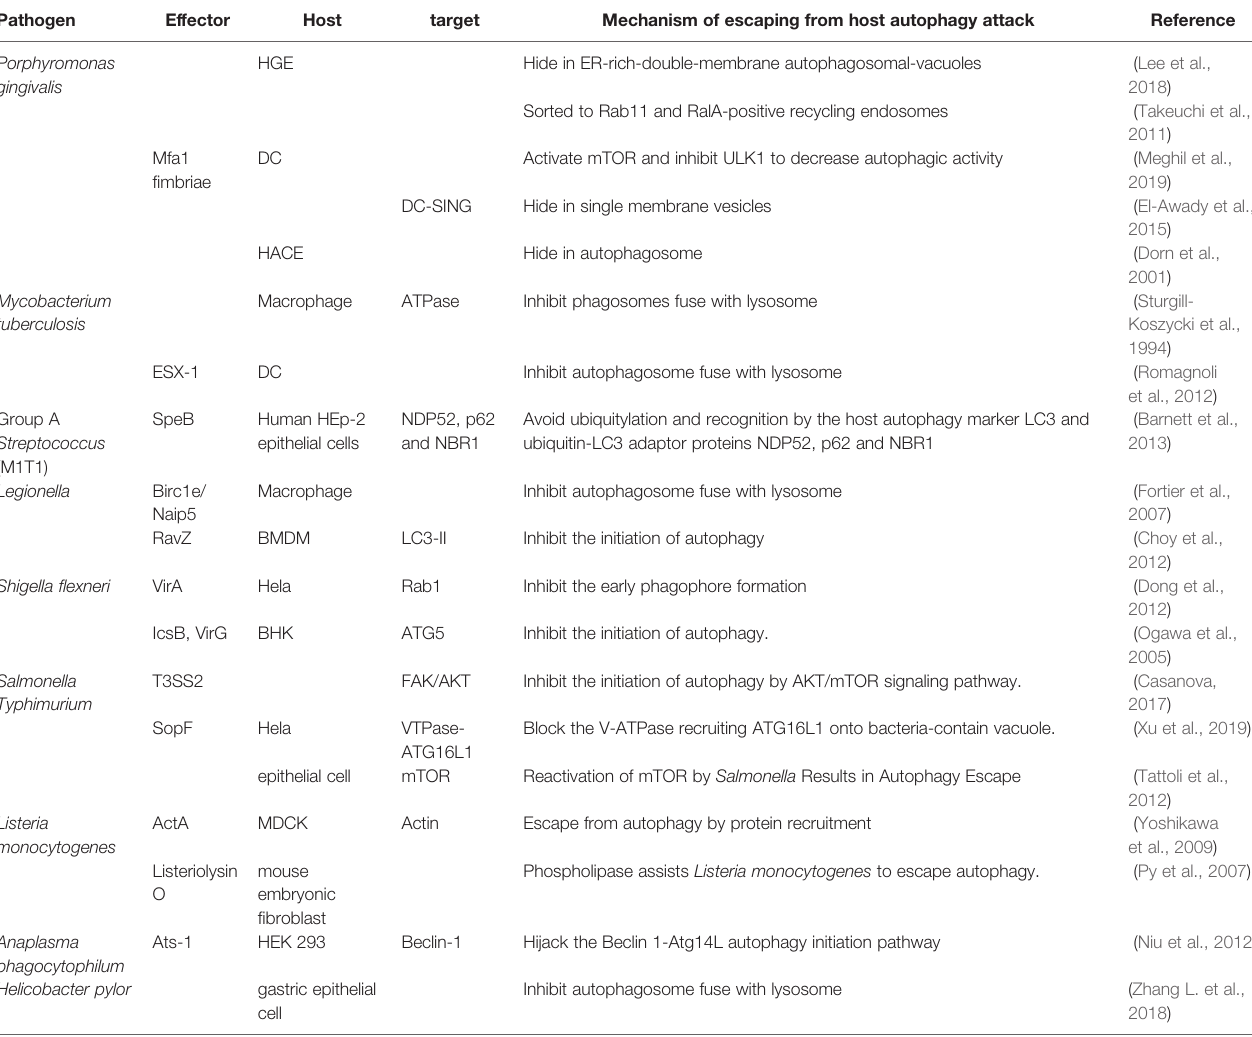
TABLE 1 | Summary of the mechanisms how the bacteria interact with autophagy.